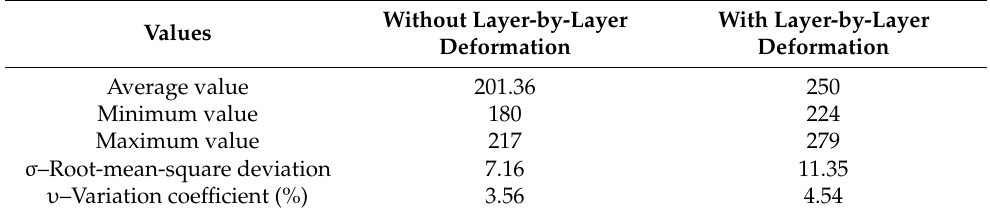
Table 2. Microhardness HV0.1 of the samples produced using different process variants.